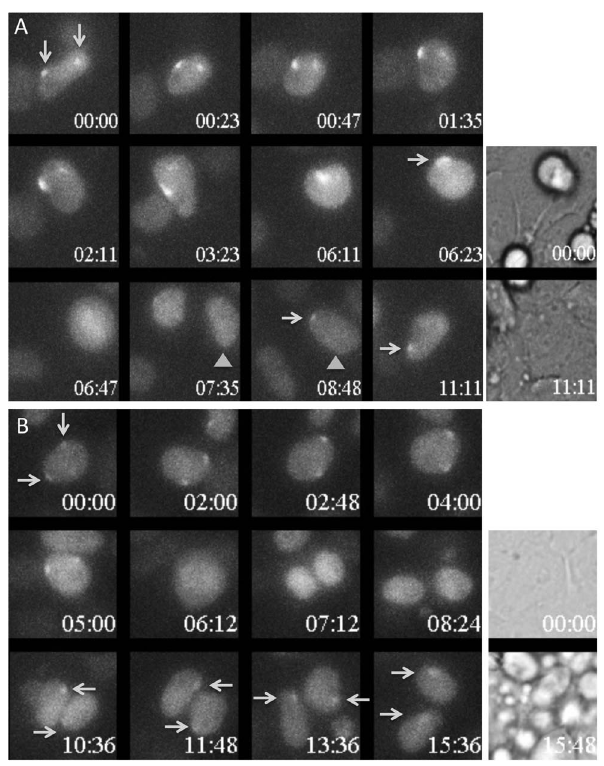
Fig. 4. Cells presenting two nuclear domains of accumulation of Ezh2-Venus demonstrate occasional instability in Ezh2-Venus recruitment. In both A and B, the 12 left panels show wide-field fluorescent maximum projection images of Z-stacks in Venus channel at selected time points during differentiation of the Z8.1 ES cell line. Time is indicated relative to the start of the sequence shown (hours: minutes). The white arrows point to the Ezh2-Venus accumulation foci. When necessary, gray triangles allow unambiguous identification of the cell that could be followed in two successive panels. Transmission images at the start and the end of the sequence are shown in the two panels on the right. It was verified that the nuclei had been fully imaged in Z by examining individual plans of the Z-stacks. Full time-lapses corresponding to these stills are shown in S4 Video and S5 Video. A) The initial time in this sequence corresponds to 44 hours and 50 minutes after shifting from 2i plus LIF to EpiLCs culture conditions. In this cell with two fluorescent territories (arrowed), one of the two Ezh2-Venus territories of accumulation faded away with a 6 hours time course. 3 hours and 30 minutes after mitosis, one of the daughter cells still presented a single fluorescent territory (arrowed). B) The initial time in this sequence corresponds to 42 hours and 35 minutes after shifting from 2i plus LIF to EpiLCs culture conditions. Daughter cells exhibited only a single Ezh2-Venus territory of accumulation over more than 6 hours despite the fact that the mother cell had two domains